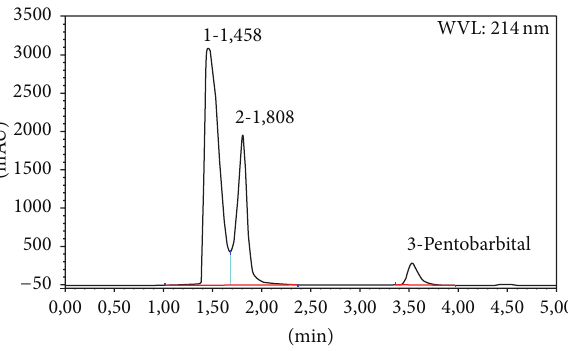
Figure 3: Chromatogram of 3% hydrogen peroxide treated pento- barbital sodium at 50 ∘ C for 48